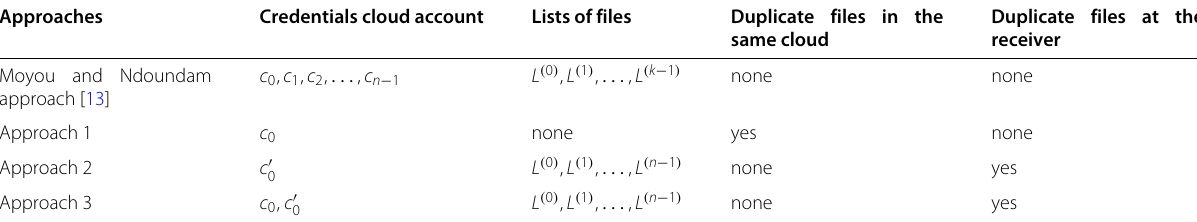
Table 8 Comparison of our approaches and Moyou and Ndoundam’s approach based on the key and management of the cloud storage environment